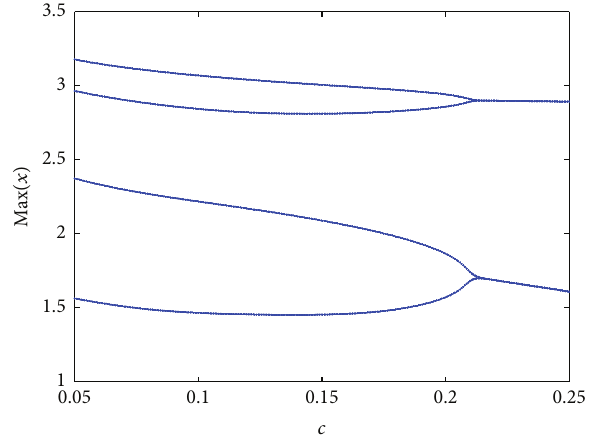
Figure8:Thebifurcationdiagraminplane 𝑐, 𝑥 with 0.05 ⩽ 𝑐 ⩽ 0.25 , 𝐴 = 0 , 𝑚 = 0.3 , 𝑏 = 0.2 , 𝑑 = 0.8 , 𝛽 = 2.4 , 𝛼 = 1.7 , ℎ = 1.2 , and 𝜔 = 0.6 .